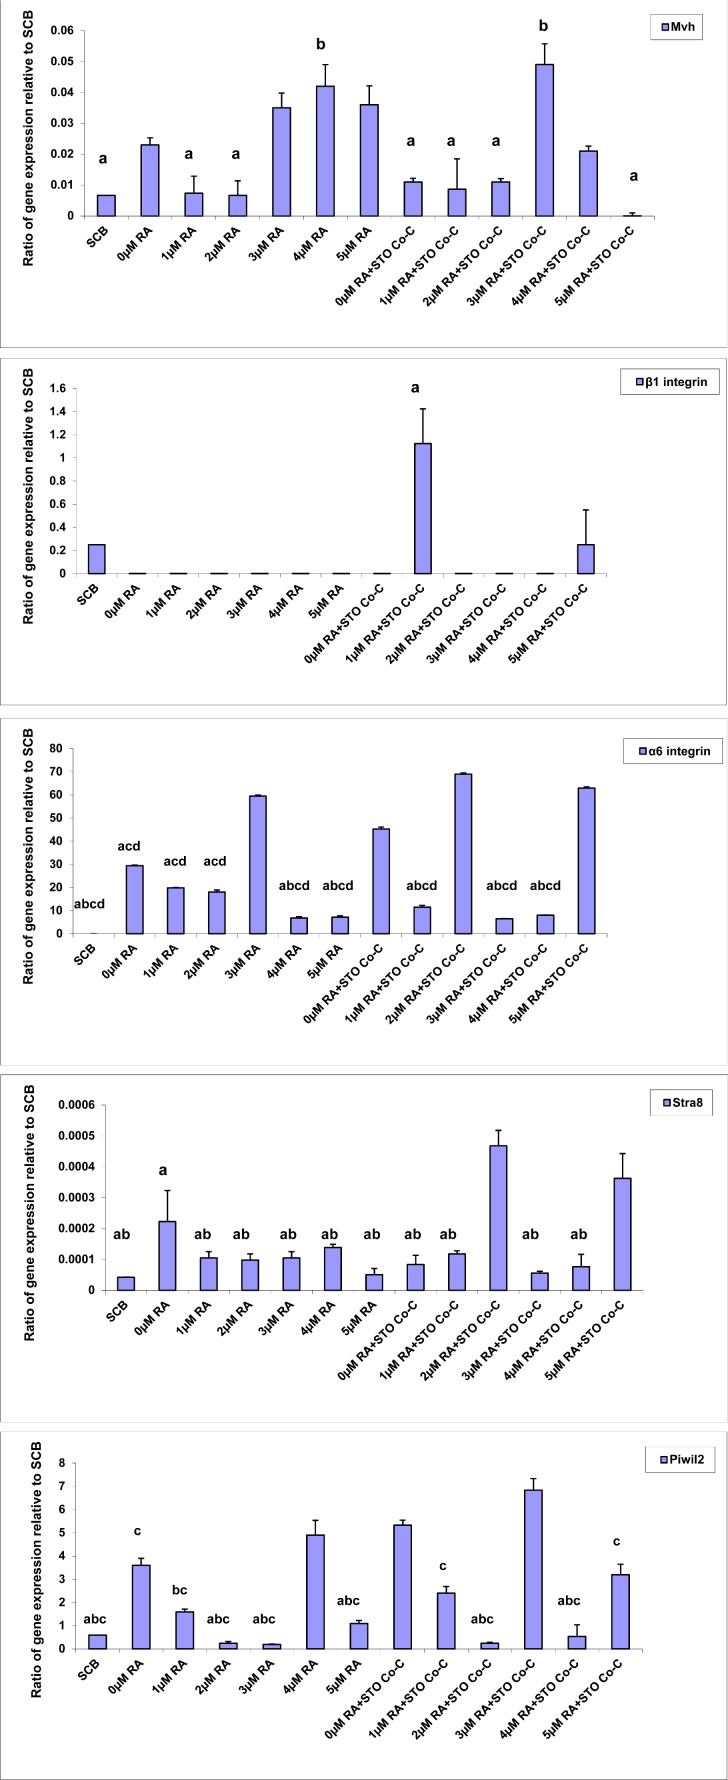
Gene expression profiling analysisRatio of genes expression in 0–5 μM RA concentrations and 0–5 μM RA concentrations+STO Co-C groups relative to simple culture with BMP4 (SCB) group. In the Mvh graph, ashows significant difference with 3 μM RA+STO Co-C and bdemonstrates significant difference with 5 μM RA+STO Co-C groups. In the α6 integrin chart, ashows significant difference with 0 μM RA, bdemonstrates significant difference with 0 μM RA+STO Co-C, cindicates significant difference with 2 μM RA+STO Co-C and dreveals significant difference with 5 μM RA+STO Co-C groups. In the β1 integrin diagram, ashows significant difference with other groups. In the Stra8 graph, ashows significant difference with 2 μM RA+STO Co-C and bdemonstrates significant difference with 5 μM RA+STO Co-C groups and in the Piwil2 chart, ashows significant difference with 4 μM RA, bdemonstrates significant difference with 0 μM RA+STO Co-C and cindicates significant difference with 3 μM RA+STO Co-C groups (P<0.05).